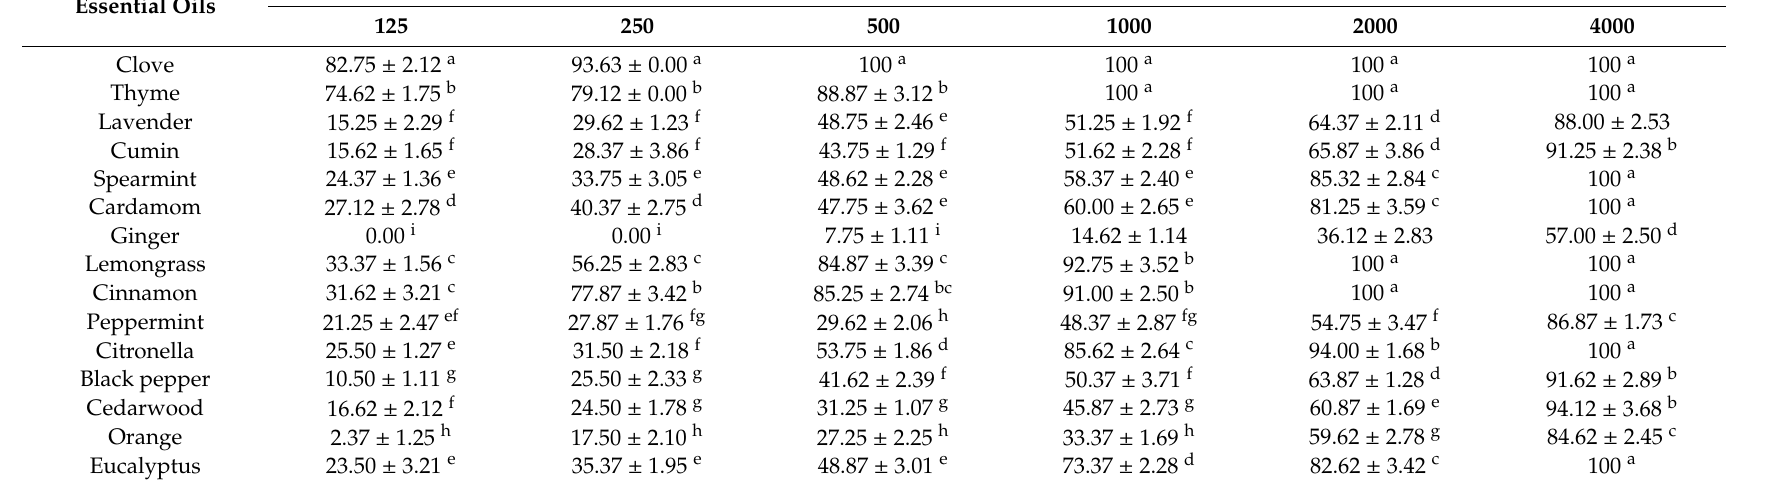
Table 1. Inhibitory e ff ect (%) of fifteen essential oils measured by the zone of clearance on the mycelial growth of A. flavus, isolated from peanuts, after 7 days of